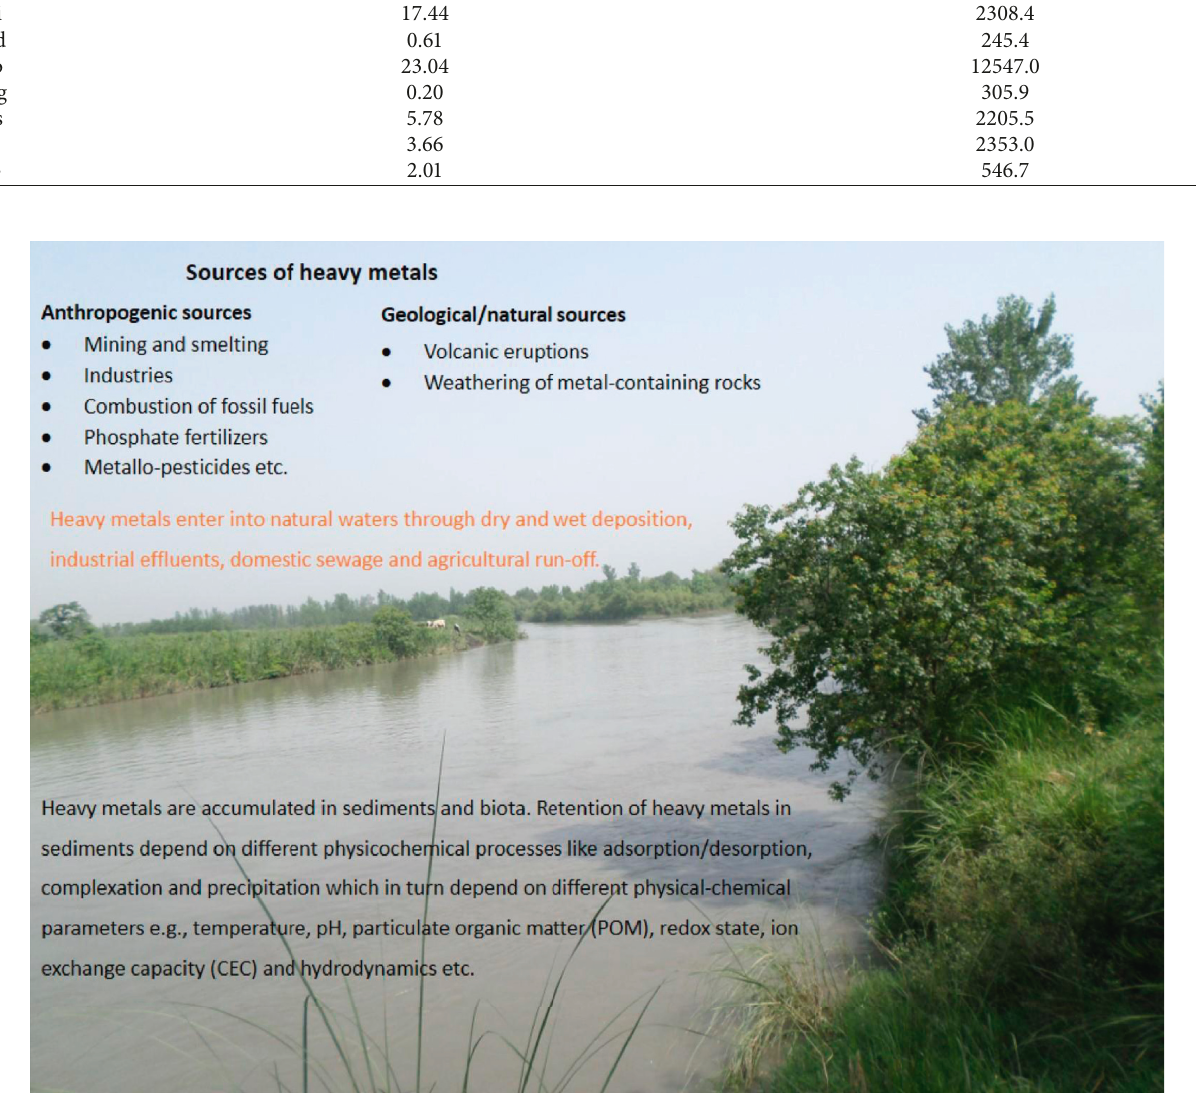
Figure 1: Schematic showing contamination of a river with heavy metals.